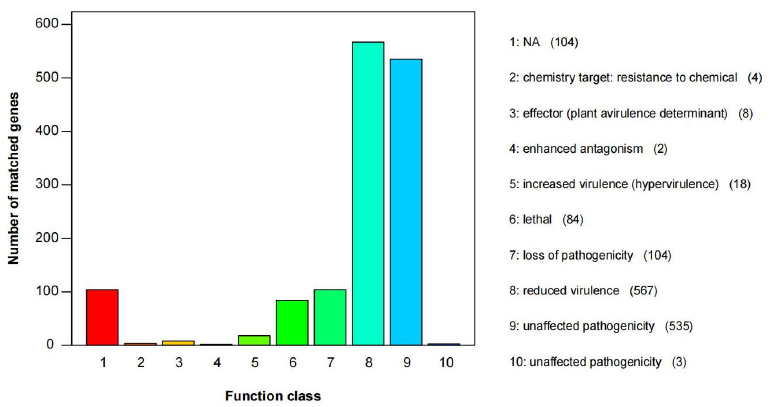
Figure 5. PHI functional annotation of C. mycophilum BJWN07.